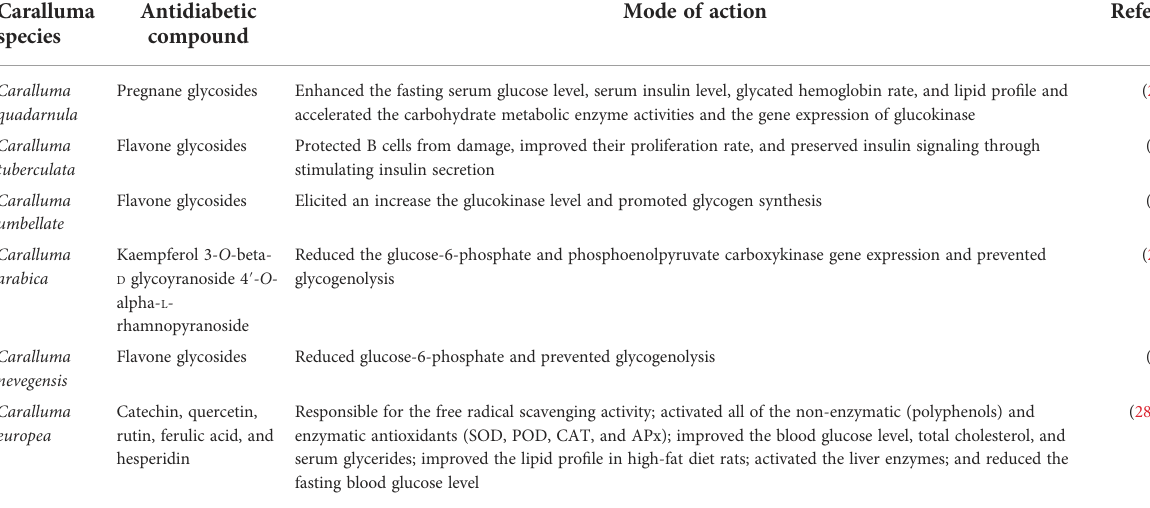
TABLE 1 Antidiabetic compounds in the genus Caralluma and their modes of action.